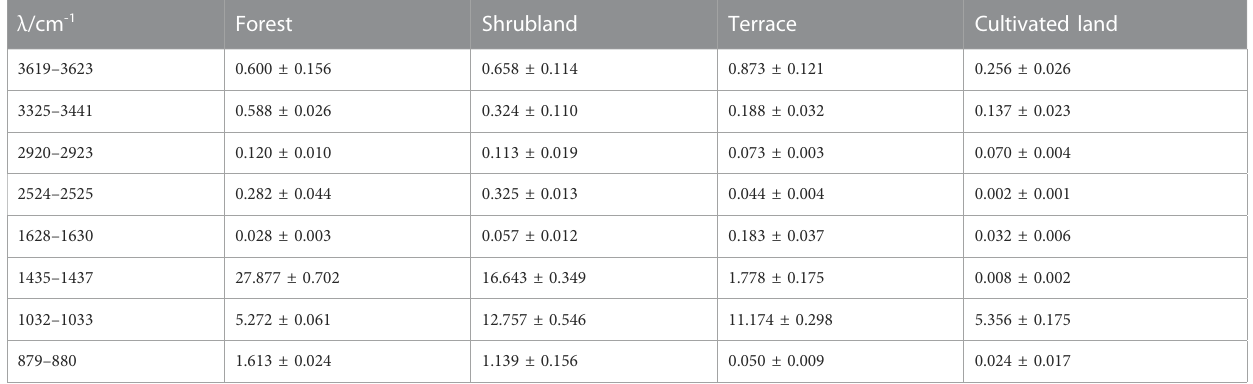
TABLE 3 Integral of the relative peak area of main peaks of the FTIR spectrum. λ /cm